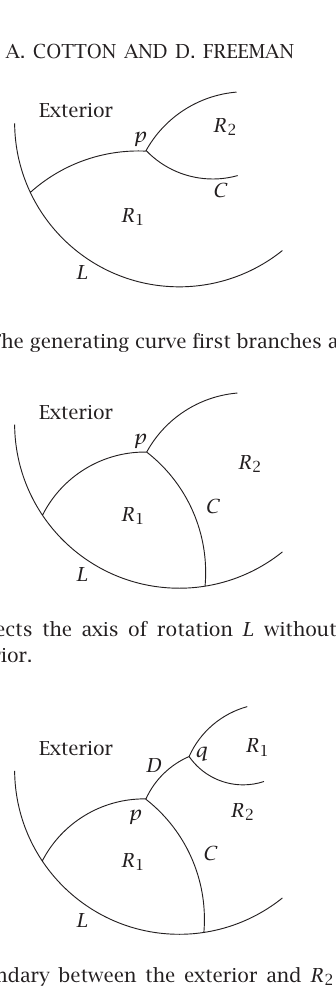
2 first branches at